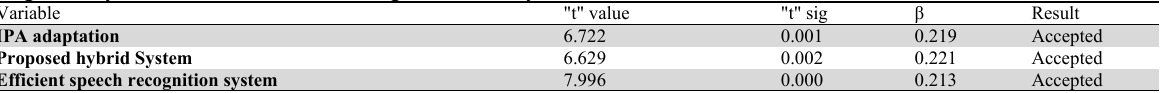
Multiple Regressions Analysis on the Relationship between the of adapting IPA, proposing hybrid system and efficient speech recognition system in in the effective management of daily user’s